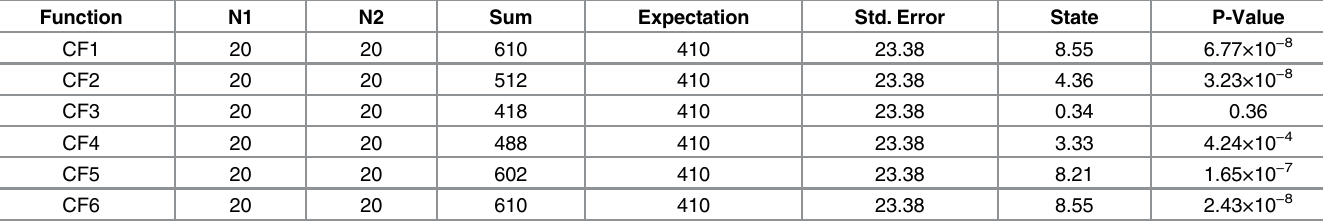
Table 7. Wilcoxon's rank-sum test between GSA and ECGSA for composition functions.